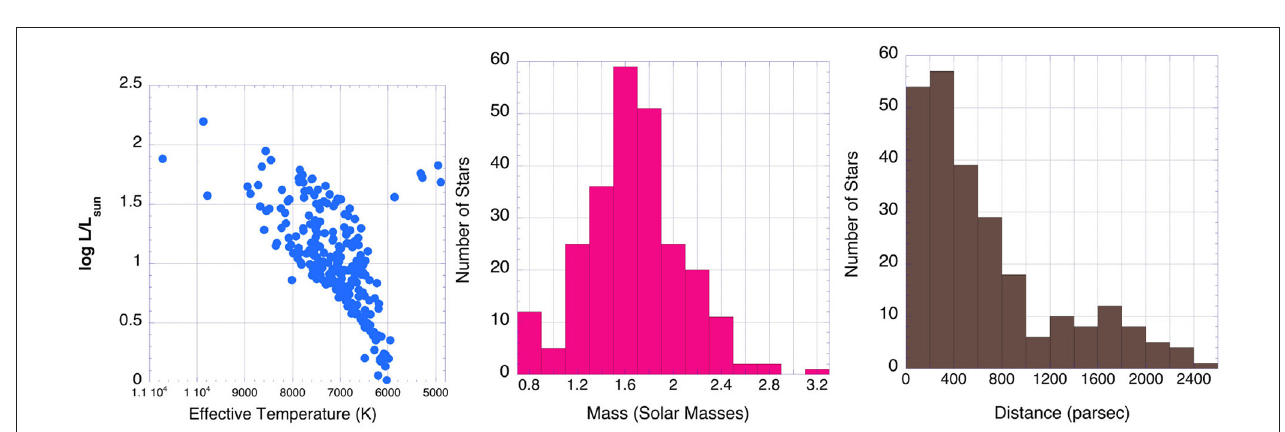
FIGURE 11 | H-R diagram (Left) , mass distribution (Center) , and distance distribution (Right) of 249 δ Sct candidates, based on EPIC catalog quantities.